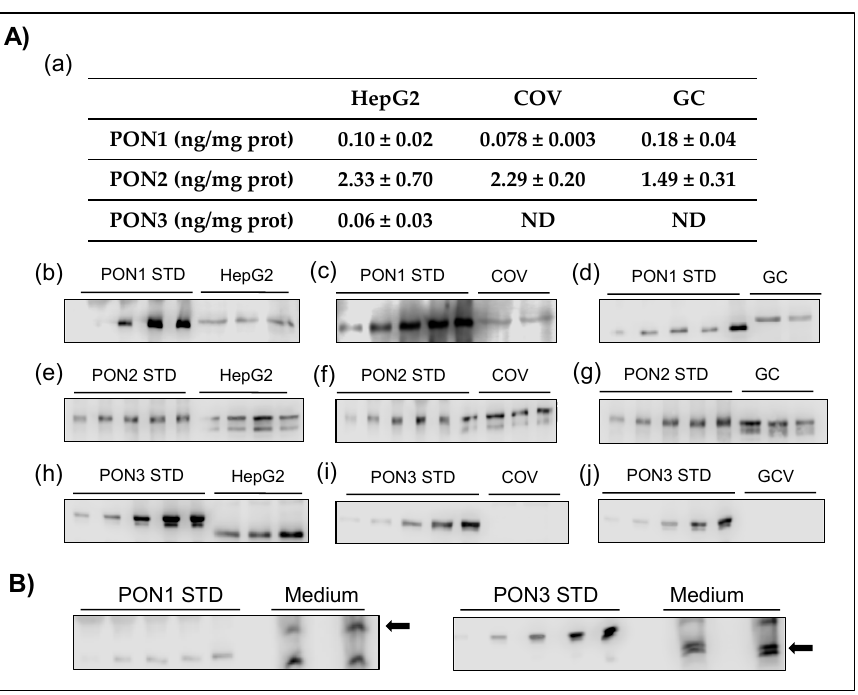
Figure 2. Expression of ( A ) PON1, PON2, and PON3 proteins in HepG2, COV434 (COV), and granulosa cells (GC), and ( B ) PON1 and PON3 proteins in the conditioned medium of granulosa cells after 48 h of incubation. ( a ) The table represents mean values ± SE of the amounts of quantified PON1, PON2, and PON3 in the different cell types. PON3 was not detected in COV434 or granulosa cells. STD lanes indicate increasing concentrations of the corresponding commercially available standard human recombinant protein from which the standard curves were derived. Arrows indicate the positions of PON proteins. ND, not detected.